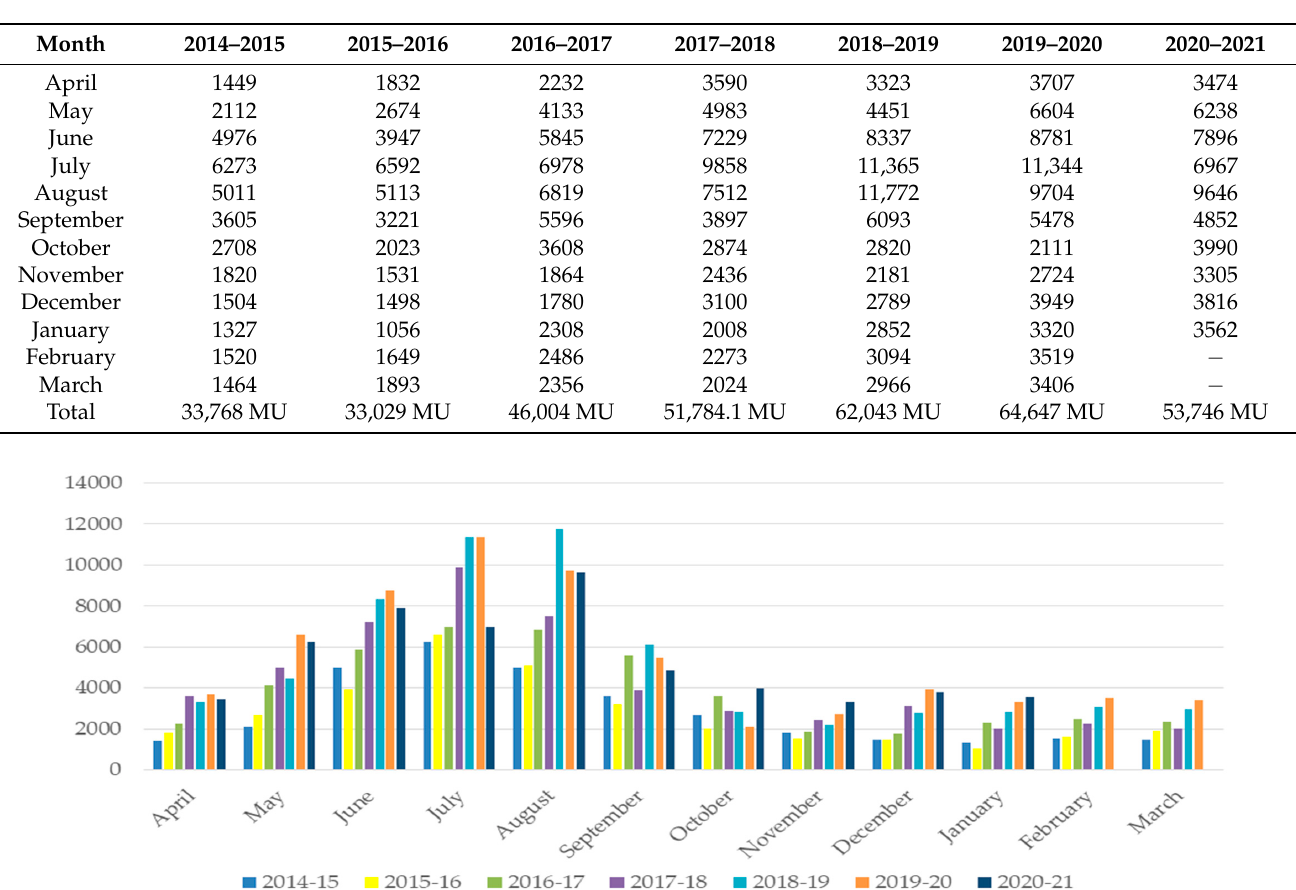
Table 19. The monthly quantum of energy produced from wind energy (MU) during financial years